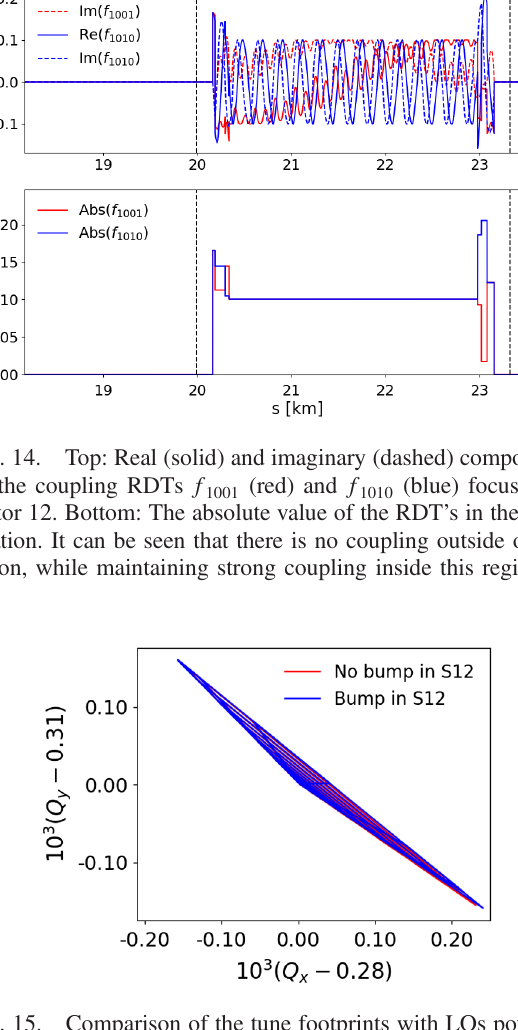
FIG. 15. Comparison of the tune footprints with LOs powered only in S81 and no coupling bump in S12 (red) or with coupling bump in S12 (blue). No impact on the footprint can be